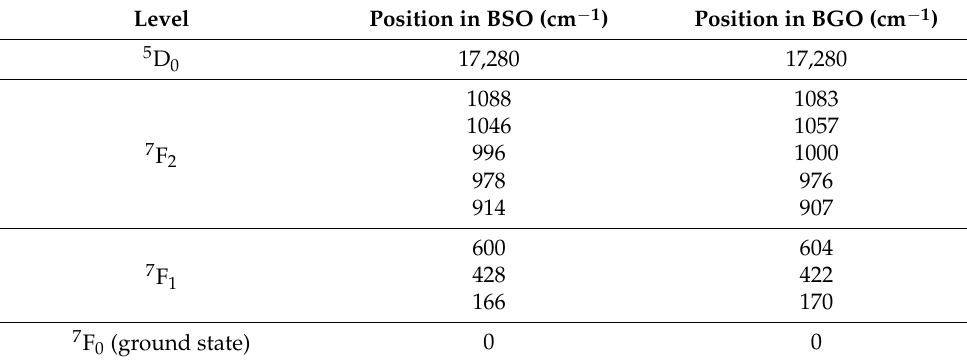
Table 3. Partial energy structure of Eu 3+ determined from observed emission transitions from the 5 D 0 state for BSO and BGO